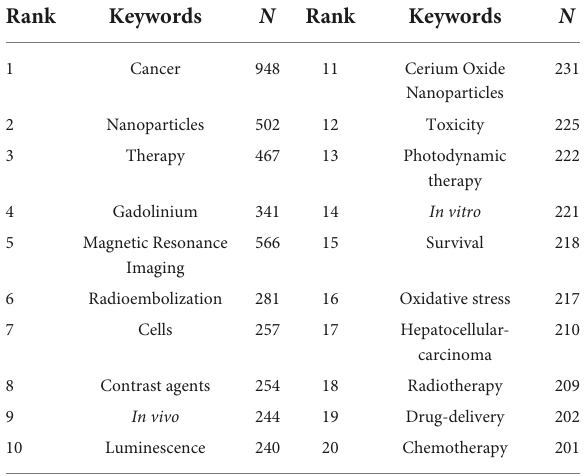
TABLE 5 The top 20 keywords in terms of frequency in the research on the association of rare earth elements with cancer. Rank